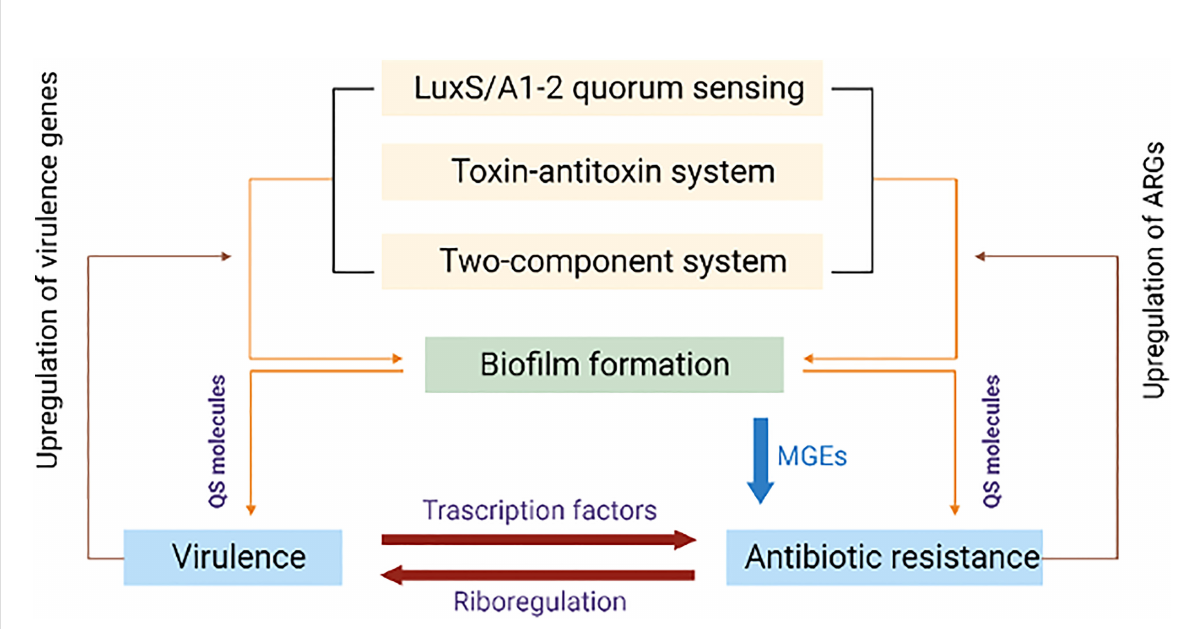
FIGURE 4 Diagrammatic representation of shared regulatory network mechanisms involving antibiotic resistance and virulence. Quorum sensing (QS), toxin-antitoxin (TAS) and two component systems (TCS) upregulate the bio fi lm formation encoding genes that successively upregulate quorum sensing molecules. These molecules in fl uence antibiotic resistance genes and virulence. Up-regulated virulence and antibiotic resistance genes consequently upregulate QS, TAS and